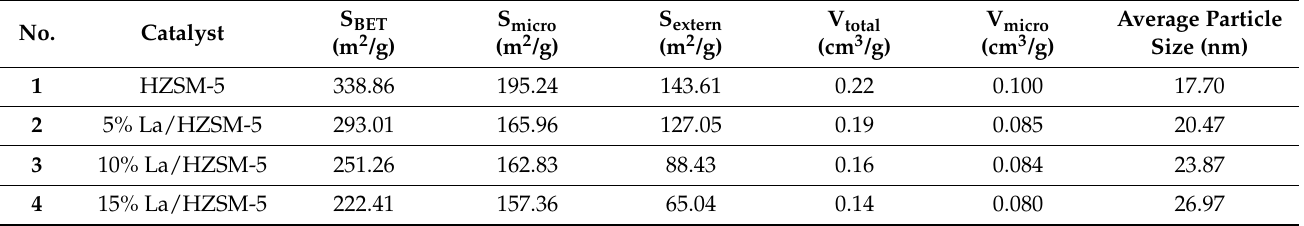
Table 1. The texture properties of the parent HZSM-5 and lanthanum-modified HZSM-5 with different loading-weight percentage-modified